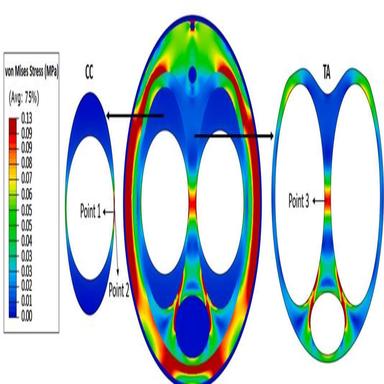
Three points chosen to compare the results between the two scenarios (this plot shows the first scenario of implantation in which the cylinder's outer diameter is 13.8 mm).